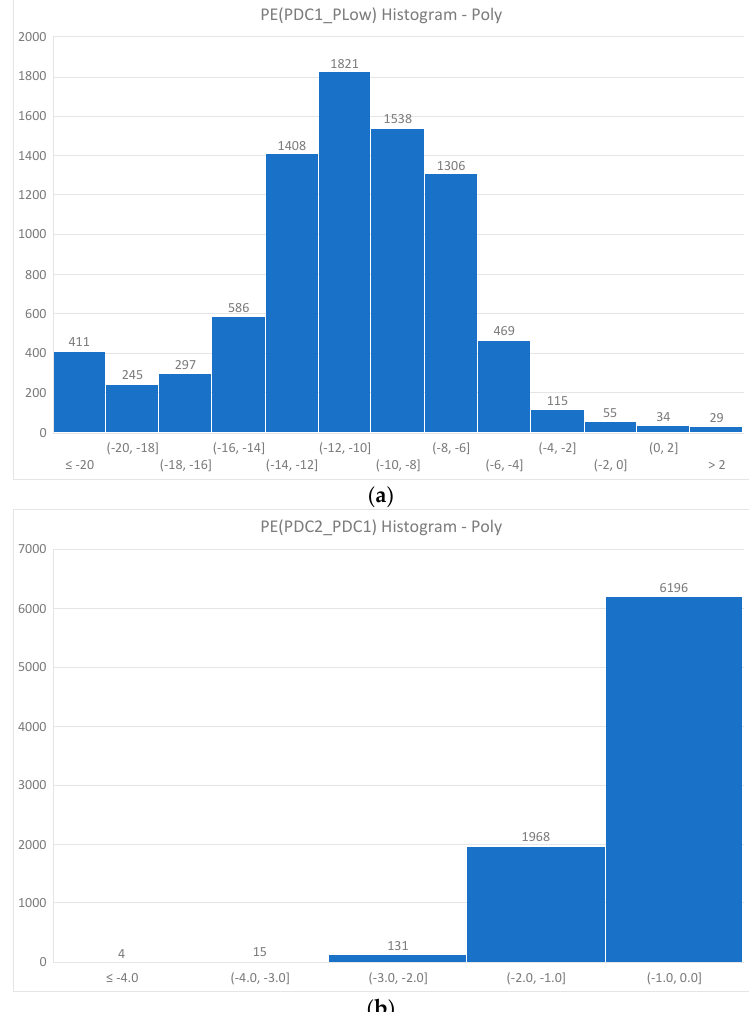
Figure 8. Histograms of the Percentage Error 𝑃𝐸 (cid:2869)(cid:3013)(cid:3042)(cid:3050) concerning 𝑃𝐷𝐶 (cid:2869)(cid:3013)(cid:3042)(cid:3050) and 𝑃 (cid:3013)(cid:3042)(cid:3050) ( a ), and the Percentage Error 𝑃𝐸 (cid:2870)(cid:3013)(cid:3042)(cid:3050) concerning 𝑃𝐷𝐶 (cid:2870)(cid:3013)(cid:3042)(cid:3050) and 𝑃𝐷𝐶 (cid:2869)(cid:3013)(cid:3042)(cid:3050) ( b ); polycrystalline modules.